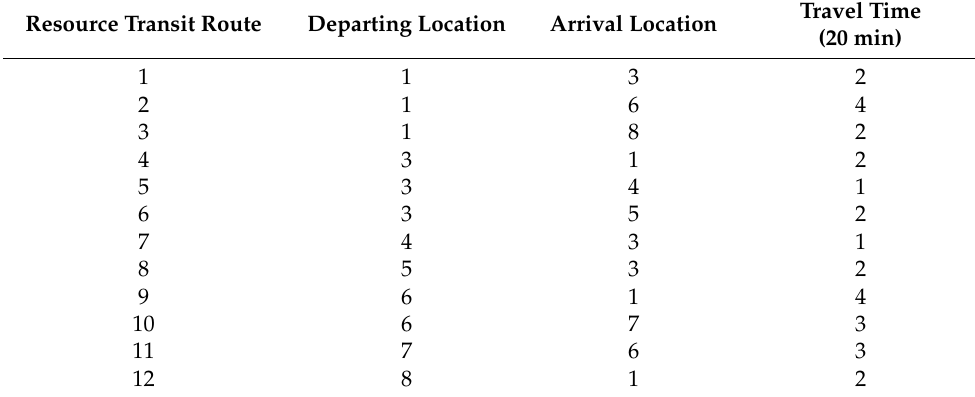
Table 7. Resource transit routes and travel times in the initial stage of a disaster (Case